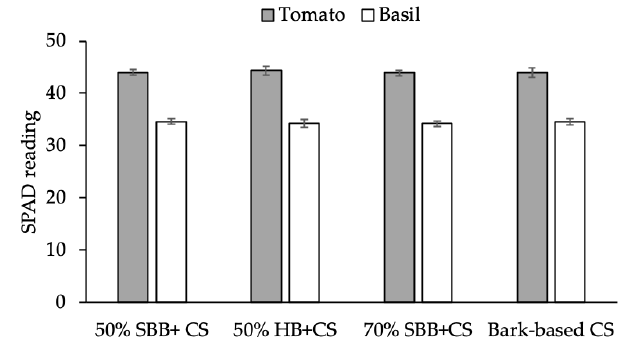
Figure 6. The soil-plant analyses development (SPAD) (mean ± standard error) of tomato and basil grown in container mixes with 50% sugarcane bagasse biochar (SBB), 50% mixed hardwood biochar (HB), and 70% SBB (by vol.), mixed with bark-based commercial substrate (CS).